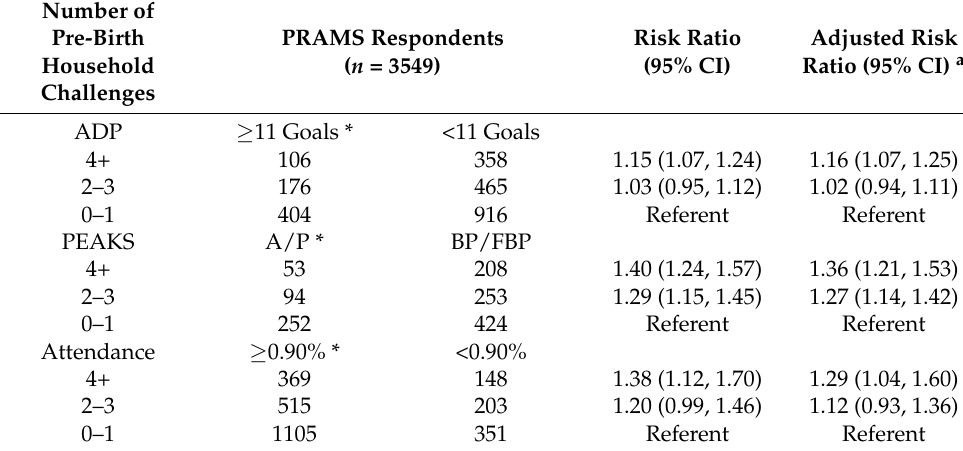
Table 3. Relative comparison of expected kindergarten developmental profile score, third grade reading proficiency score, and average school attendance rate by number of pre-birth household